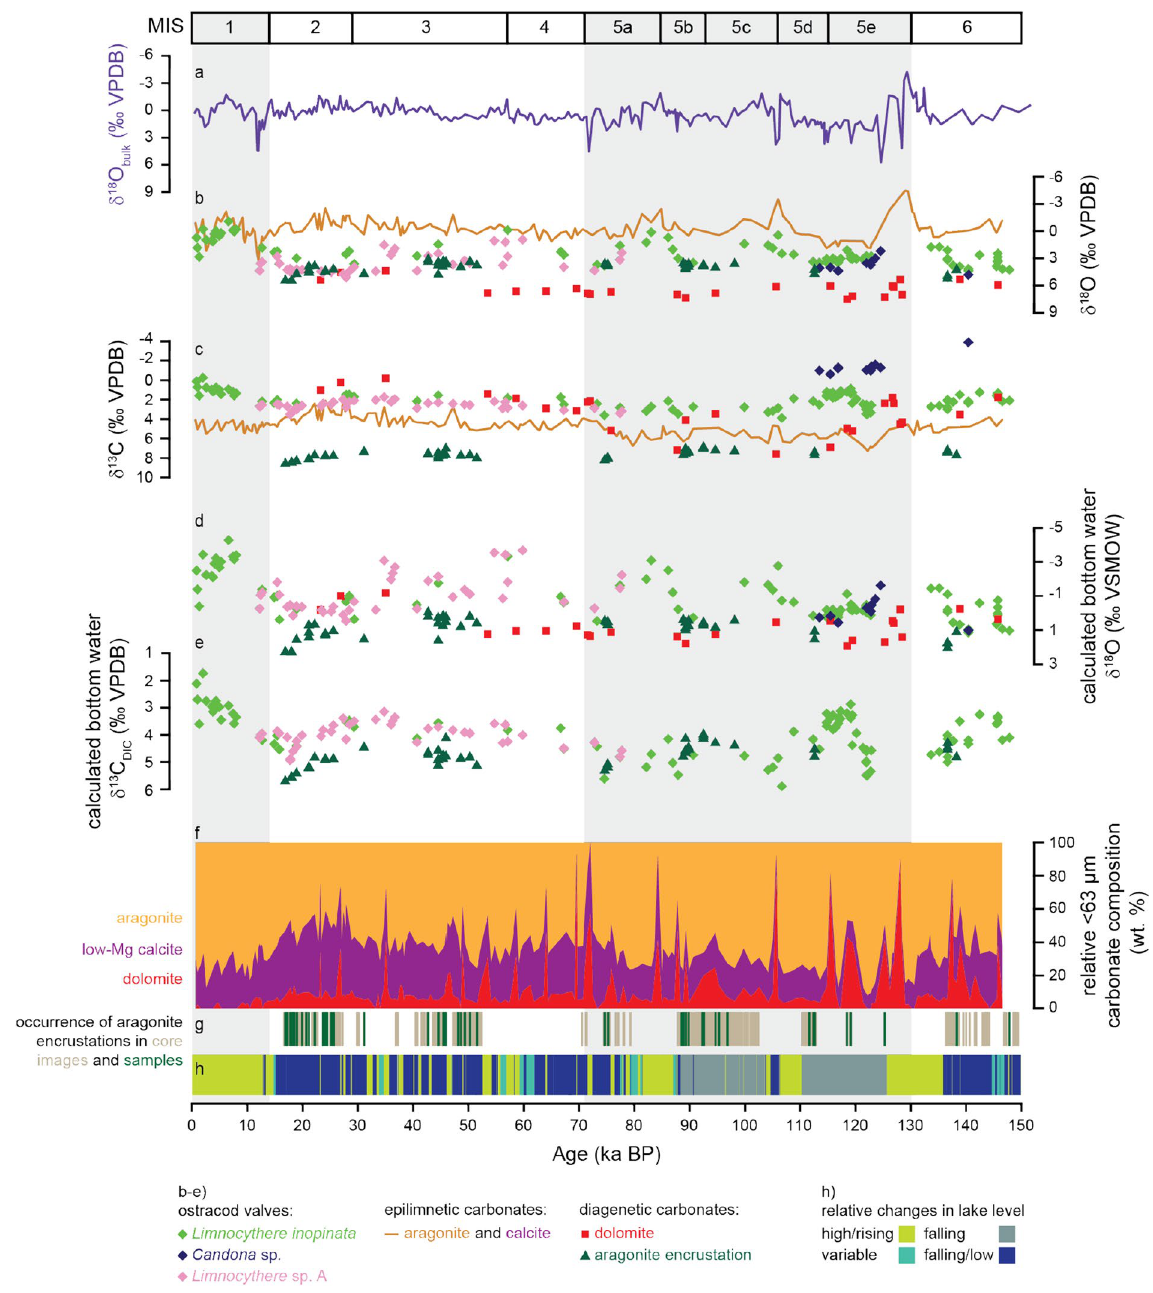
Figure 3. Isotopic variability in the Ahlat Ridge profile. ( a ) Bulk oxygen isotopy (δ 18 O bulk ) 9 . ( b ) δ 18 O of different carbonate phases and (b) δ 13 C of different carbonate phases 14,25,31 . ( d ) Estimated bottom-water δ 18 O from deep-water carbonates, calculated for a constant temperature of 3.3 °C and using mineralogy specific fractionation factors (calcite 32 , aragonite 27 , dolomite 26 ). For ostracod calcite a constant vital offset was assumed (0.8 ‰ for L. inopinata 35 , 2.2 ‰ for Limnocythere sp. A and 1.4 ‰ for Candona sp. 31 ). ( e ) Estimated δ 13 C DIC for epifaunal ostracod calcite and aragonite encrustations. Dolomite and Candona sp. are not depicted, as they likely incorporated carbon from pore-water DIC that varied isotopically from the bottom-water DIC. Estimations included a carbon isotopic offset from bicarbonate for calcite and aragonite of 1 and 2.7 ‰ respectively 48 and a vital offset of 3 ‰ for L. inopinata 35 and 2.4 ‰ for Limnocythere sp. A 31 . ( f ) relative carbonate composition 14 . ( g ) occurrence of aragonite encrustations from sieved samples (green) and anticipated from high-resolution core images (brown). ( h ) lithologies with genetic interpretations related to lake level variability as a coloured bar (simplified according to Stockhecke et al. 21 ). Note that the isotopic variability between different carbonate phases from the same stratigraphic horizon is considerable, leading to an isotopically mixed signal in bulk measurements ( a ). Marine Isotope Stages (MIS) follow Lisiecki & Raymo 51